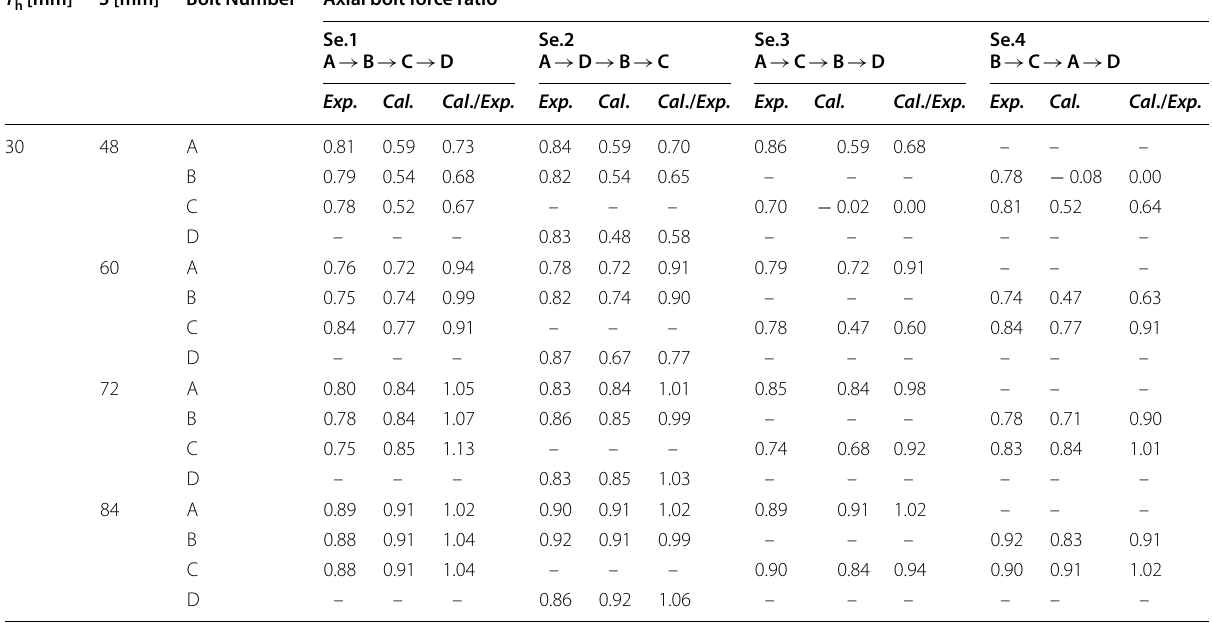
Table 6 Comparison between experimental results and calculation results for axial bolt force ratio ( T T h